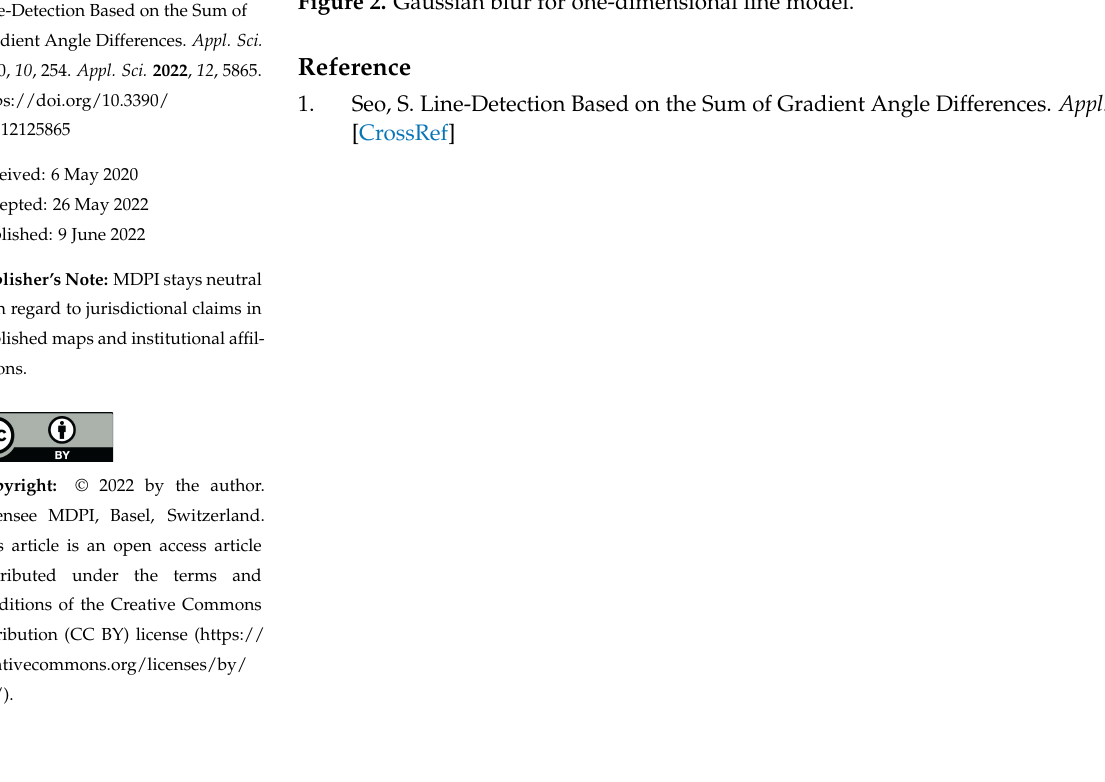
Figure 2. Gaussian blur for one-dimensional line model.